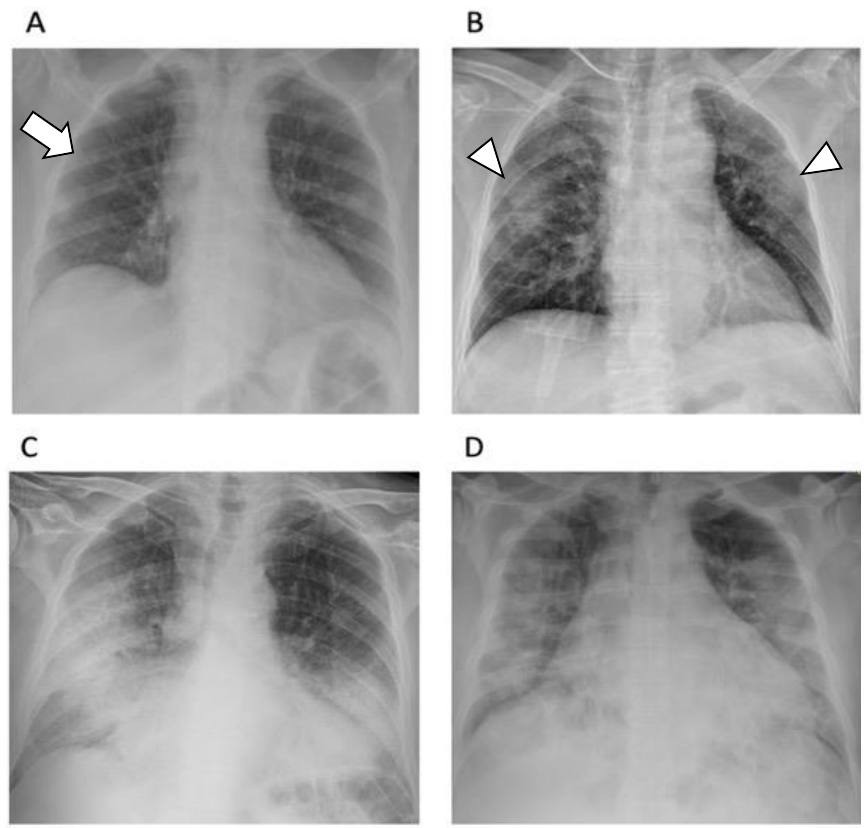
Figure 3. Chest X-ray of patients affected by SARS-CoV-2 according to the extent of lung abnormal- ities involvement. ( A ) . Lung involvement ≤25% (arrow). ( B ). Lung involvement 25 – 50% (arrow- involvement. ( A ). Lung involvement ≤ 25% (arrow). ( B ). Lung involvement 25–50% (arrowheads). heads). ( C ). Lung involvement 50 – 75%. ( D ) . Lung involvement ≥75%. ( C ). Lung involvement 50–75%. ( D ). Lung involvement ≥